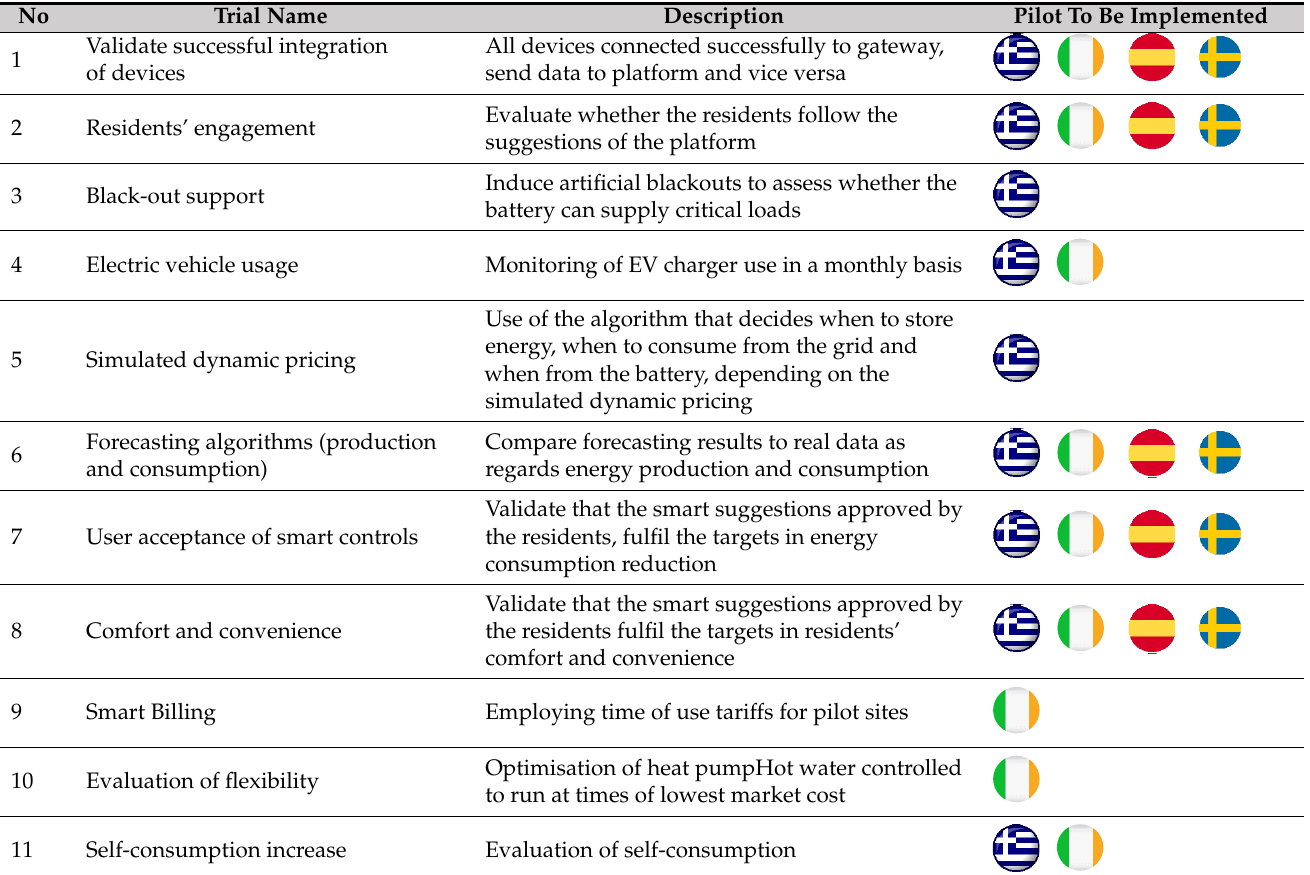
Figure 5. Pilots’ type of use and field devices. Table 5. Pilots’ Trials definition . Table 4. Pilots’ KPIs .